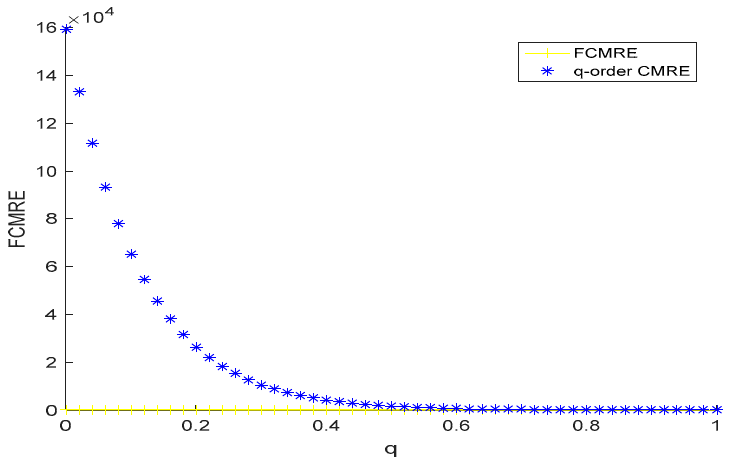
Figure 5. The fractional cumulative residual MRE of exponential distribution with λ 1 = 0.3, λ 2 = 0.8, and q-order cumulative MRE.